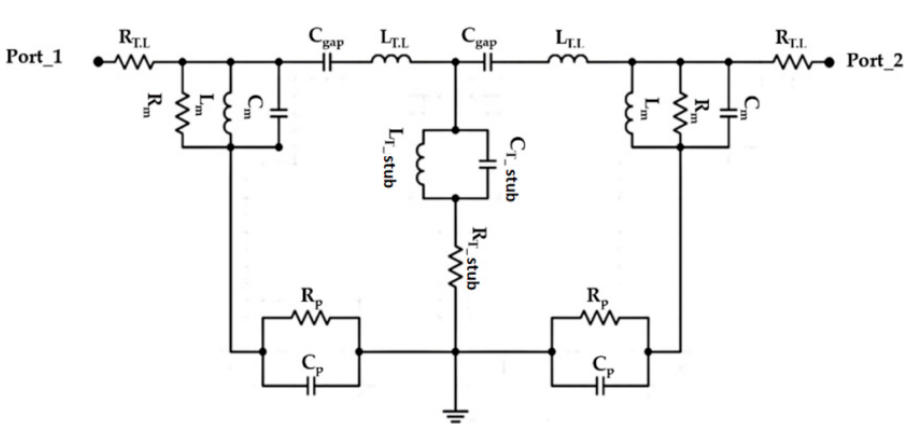
Figure 2. Equivalent circuit model.